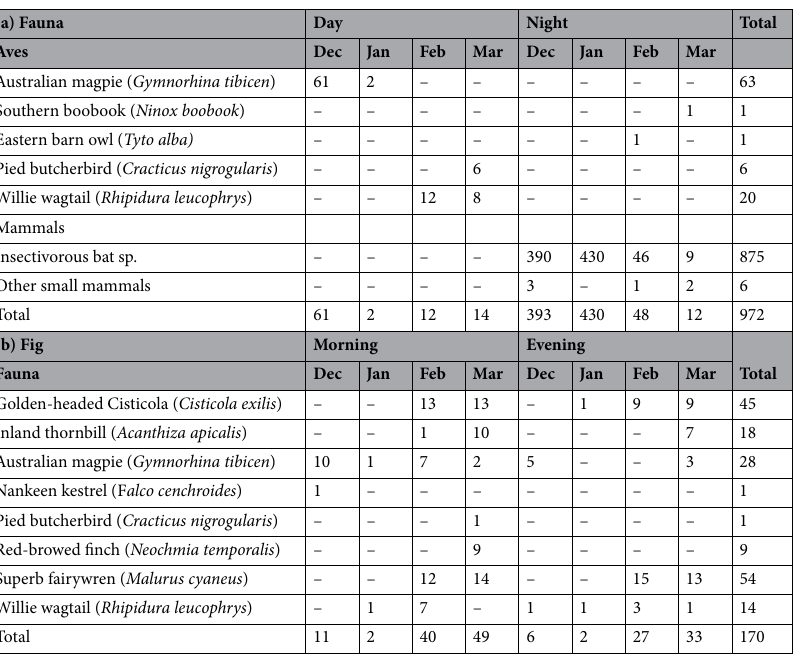
Table 3. Fauna species recorded. Number of (a) tagged images by time of day vs night and month (December to March) recorded by motion-activated cameras (b) fauna species recorded during 20-min observations of the sampling areas during morning and evening sampling sessions. Columns represent the abundance of species during the morning and evening sampling and during each month (December to